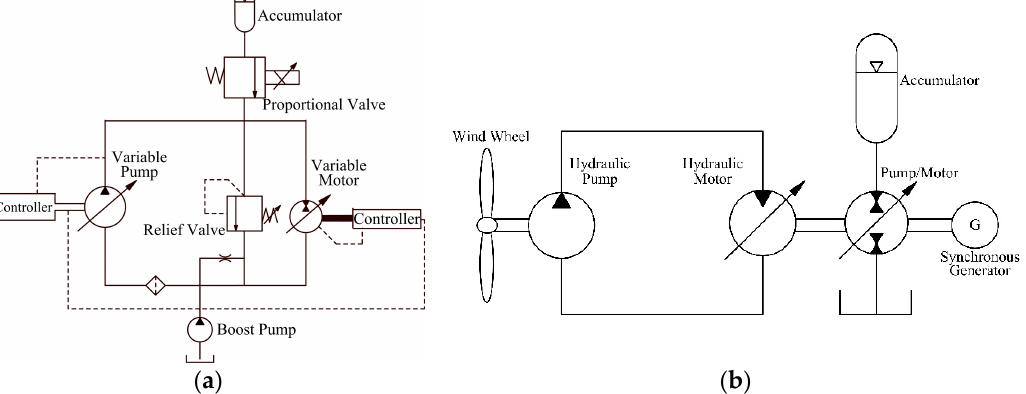
Figure 2. ( a ) The schematic diagram of Artemis Intelligent Power hydraulic wind turbine; ( b ) The schematic diagram of the Rahul Dutta hydraulic wind turbine.